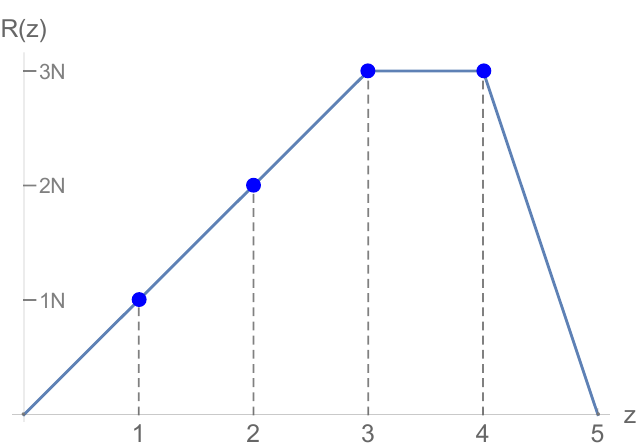
Figure 3. The rank function R ( z ) corresponding to the (cid:12)eld